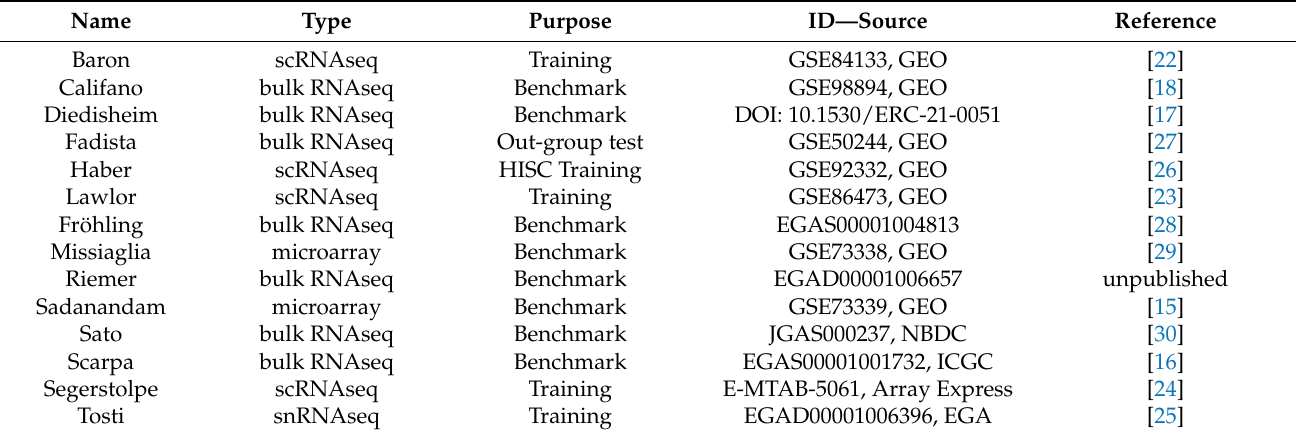
Table 1. Name, purpose with respect to transcriptomic deconvolution, source, and reference number of the respective